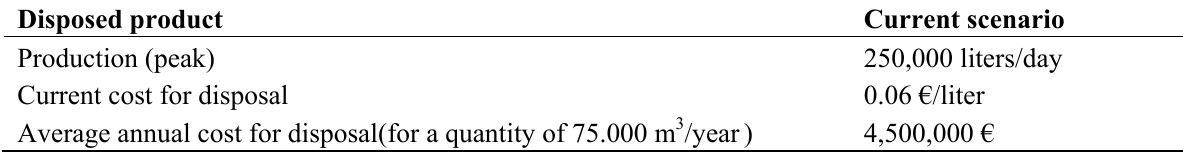
Table 1. Current situation.